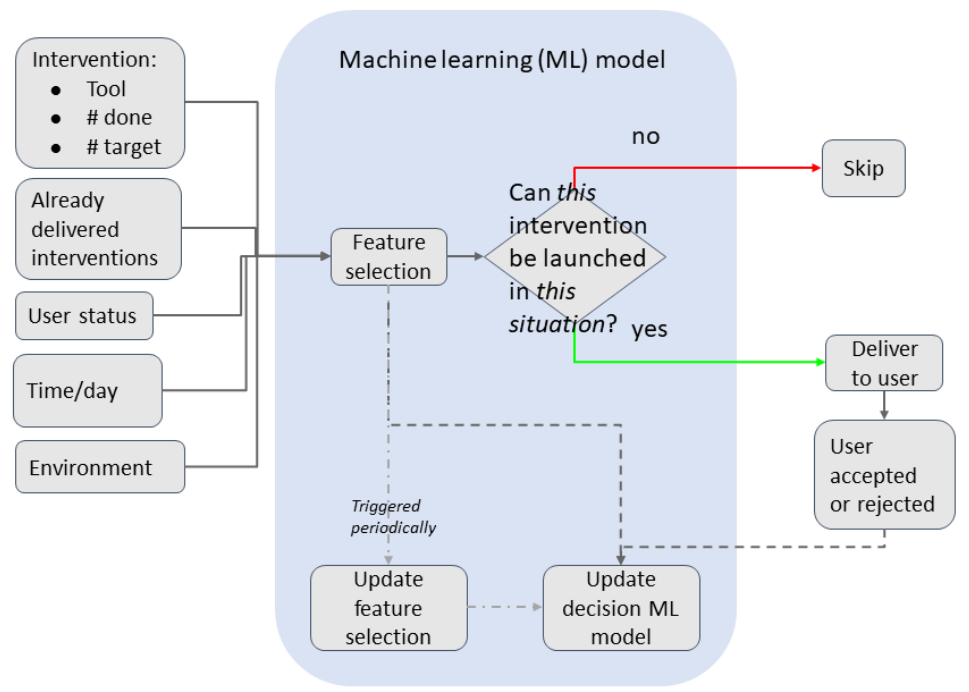
Figure 8. Incremental learning ML model training and inference.